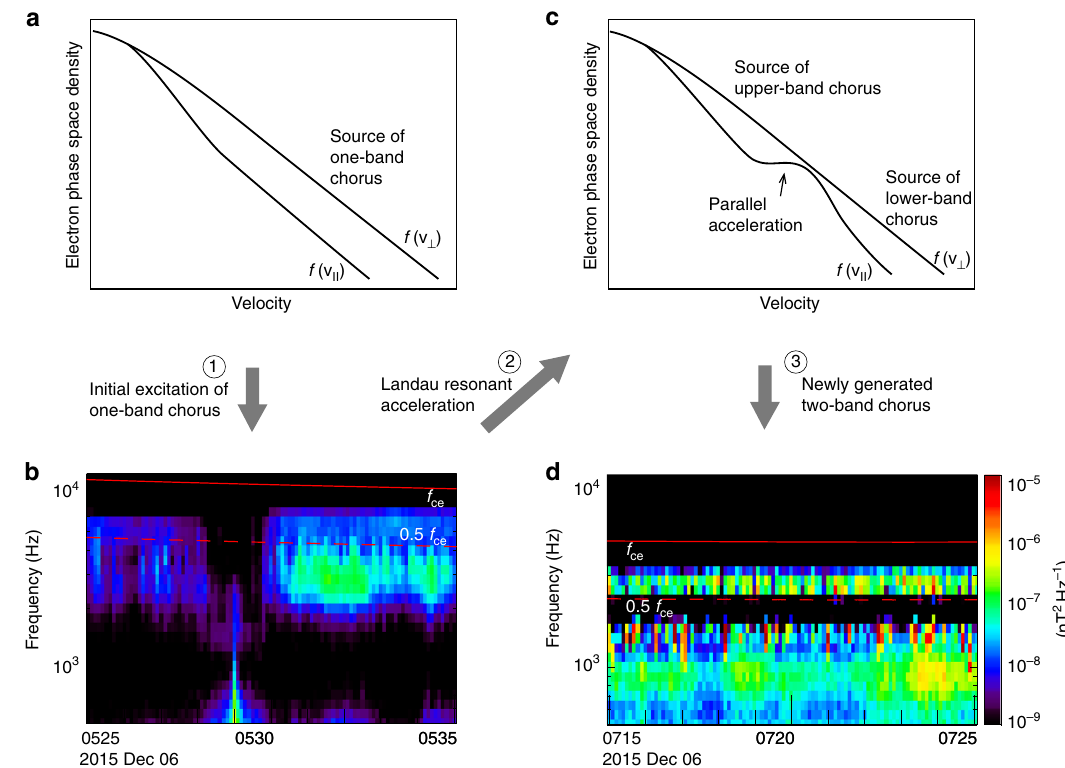
Fig. 5 Schematic illustration of the generation mechanism of two-band chorus waves. a The anisotropic velocity distribution of freshly injected electrons and b the generation of one-band chorus emissions. c The electron distribution after Landau resonant acceleration taking place, resulting in two separate anisotropic parts, d The excitation of the upper and the lower band chorus emissions by the low-energy and high-energy anisotropic electrons, respectively. The red solid and dashed lines represent f ce and 0.5 f ce , respectively. Since the Landau resonant acceleration and the formation of two anisotropic components occur very rapidly, the two-band chorus waves are more commonly observed than the one-band chorus waves. The measured electron distribution associated with the one-band and two-band chorus waves are shown in Supplementary Fig. Figure 5 schematically illustrates the generation mechanism of two-band chorus waves deduced from a combination of Van Allen Probes observations and self-consistent particle-in-cell simulations: (1) The initial anisotropic electron distribution generates a single chorus wave band over a broad frequency range (also see Supple- mentary Fig. 6). (2) These one-band chorus waves immediately accelerate electrons via Landau resonance near the equator and at higher latitudes, splitting the anisotropic electrons into two energy ranges, separated by a more isotropic range. (3) The new chorus waves are excited at the upper and lower bands by two separate anisotropic electron populations. The spectral gap is formed at 0.5 f ce , because the Landau resonant energies of chorus waves over a broad frequency range are close to the cyclotron resonant energies of chorus waves at 0.5 f ce . The separation of anisotropic electrons into two energy ranges, caused by Landau resonant parallel accel- eration, is the key process here. As it occurs very quickly, the two- band chorus wave structure is common in the outer radiation belt, while chorus waves with spectra across 0.5 f ce , which according to our model should only occur at the initial excitation stage, are relatively uncommon 60 – 62 . This study shows the complexity of the wave-particle interactions, that is, the initially excited waves cause immediate feedback to the plasma environment and signi fi cantly modify the particle distribution, which subsequently generates a new wave structure. Chorus waves, ubiquitous across planetary environments and plasma conditions, have a characteristic two-band structure whose waves play a critical role in accelerating seed electrons to relativistic